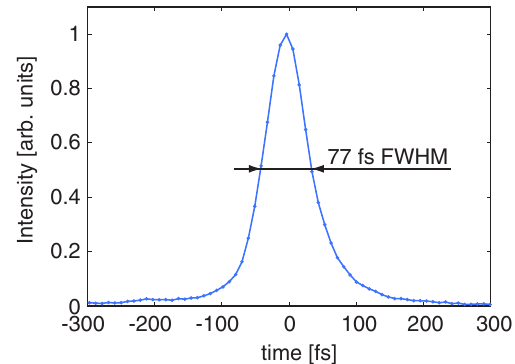
FIG. 11. (Color) Single-shot autocorrelation signal of the EOTD gate pulse. See text for details.